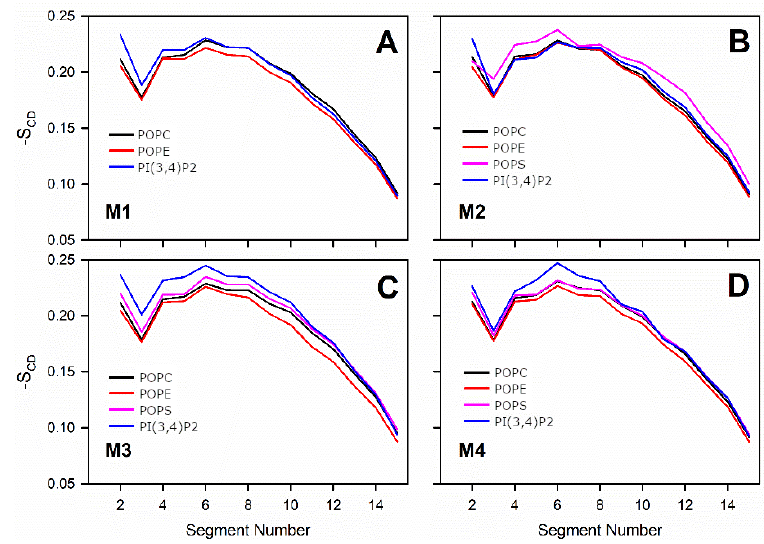
Figure 3. Molecular order parameter -S CD : comparison of the lipid species in each model: ( A ) Model #1, ( B ) Model #2, ( C ) Model #3, and ( D ) Model #4 (or M1–M4; Table 1). The different lipid species are shown with distinct colored lines (Figure 1).